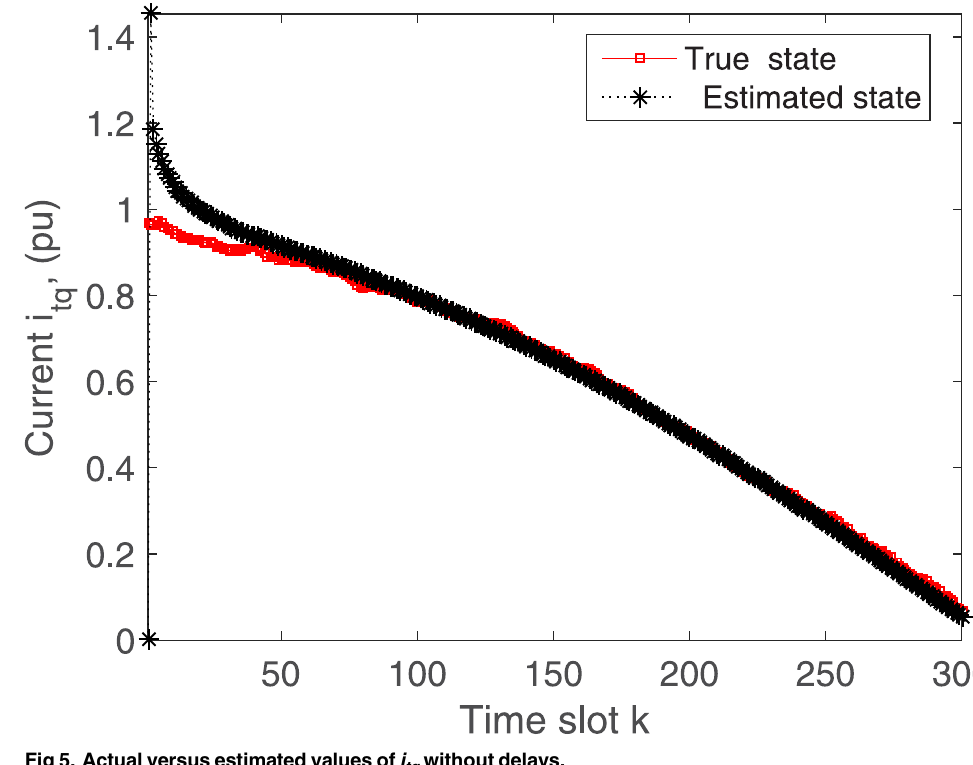
Fig 5. Actual versus estimated values of i tq without